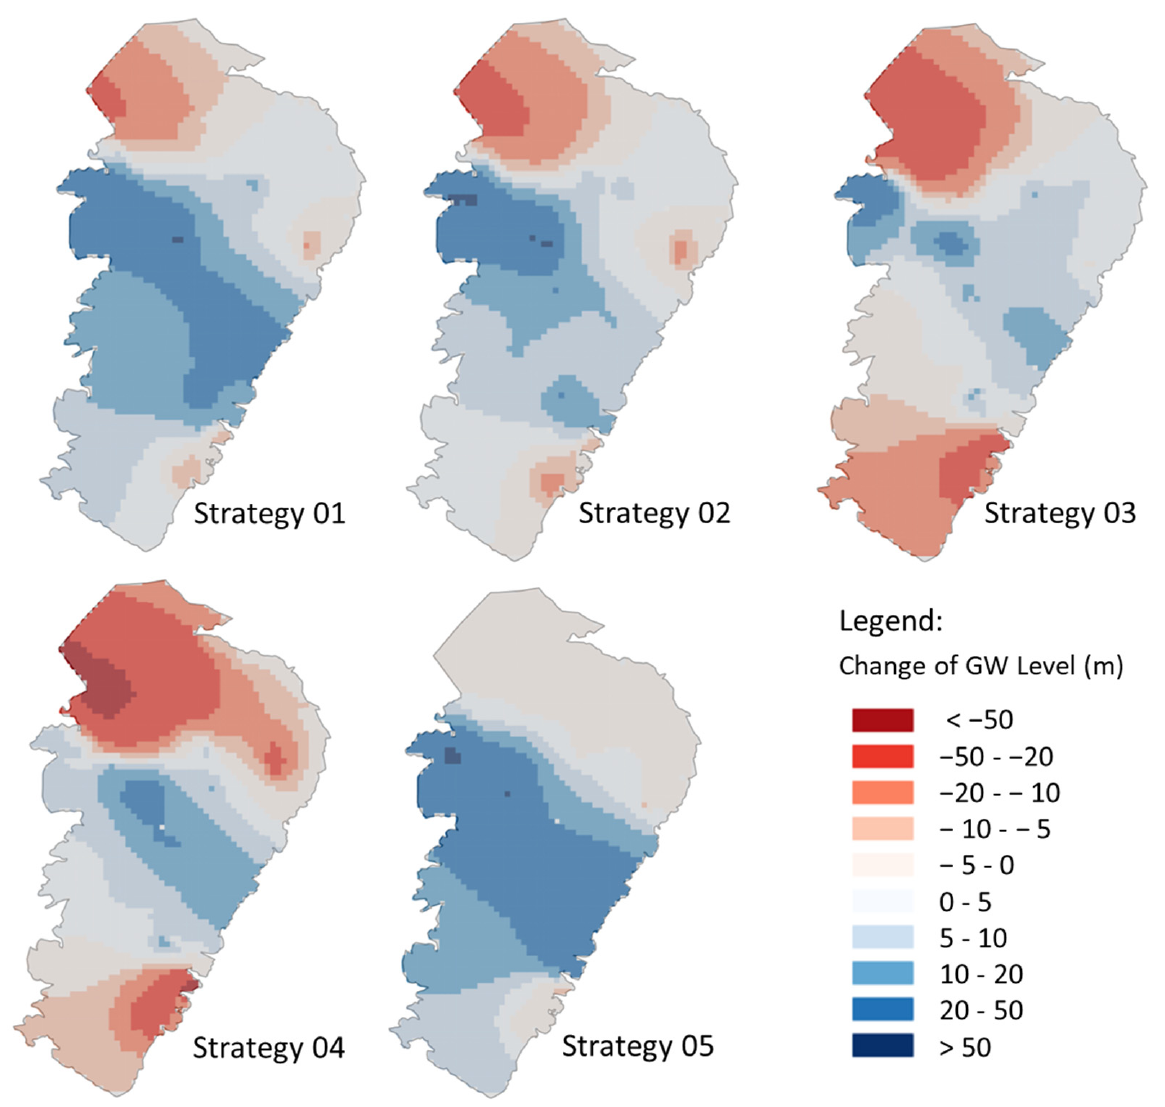
Figure 25. Change in groundwater levels compared to present condition for strategies 01–05.